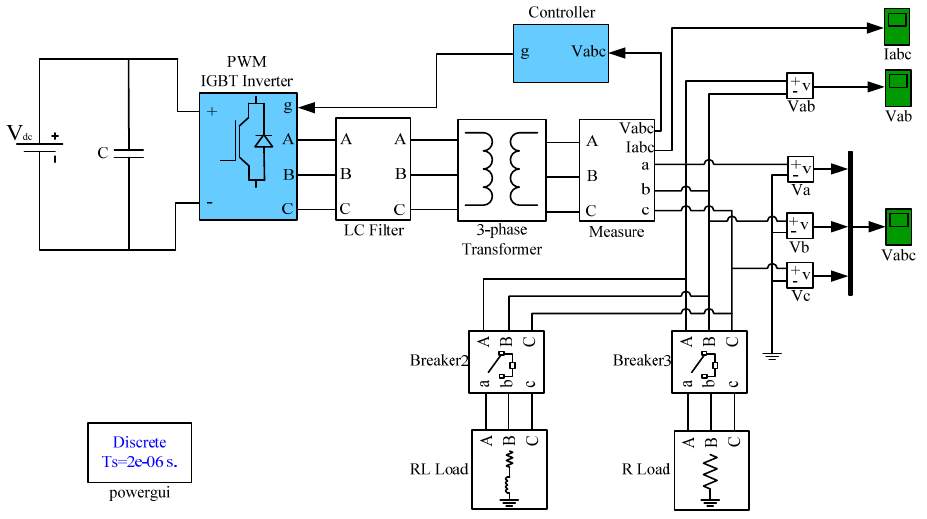
Figure 6. Simulation model for the three-phase inverter.